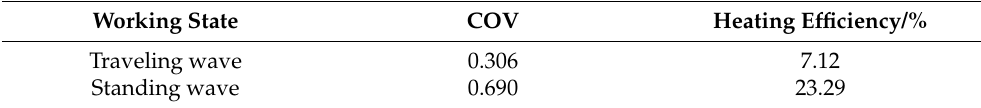
Table 3. The heating performance of the two working states.